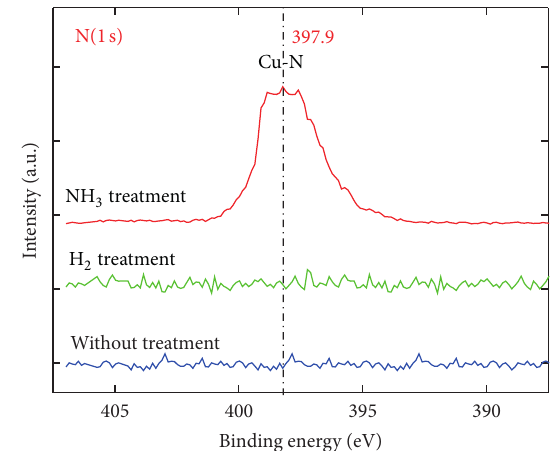
Figure 4: N (1s) XPS spectra for different plasma treatments on the Cu